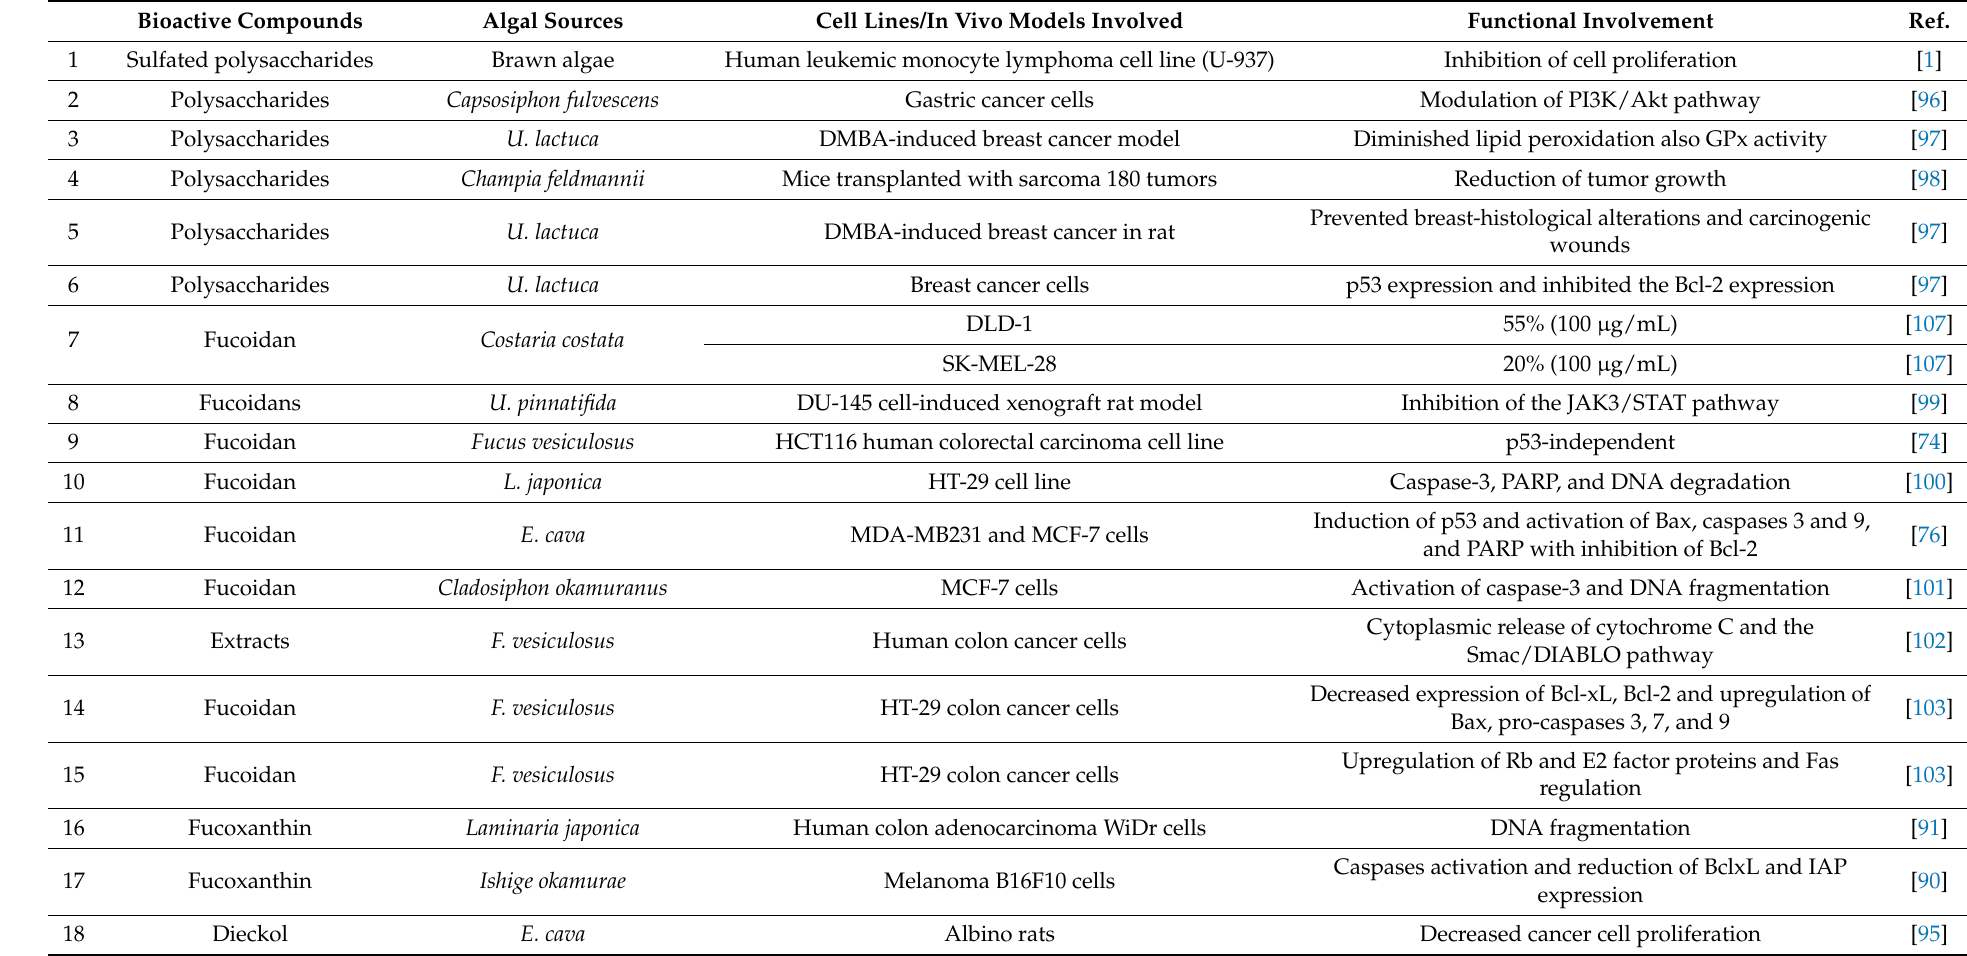
Table 1. Marine algal bioactive metabolites and their functional role in